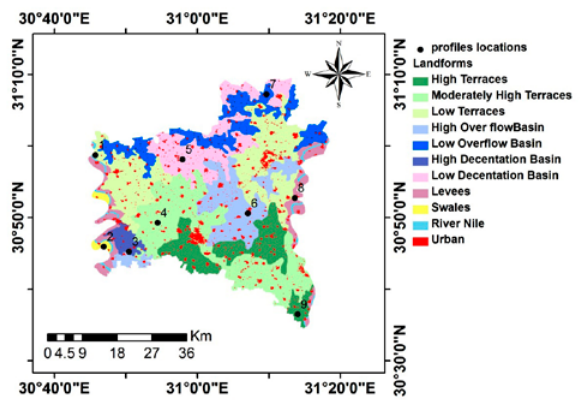
Fig. 3. The main landforms of the study area and profile locations